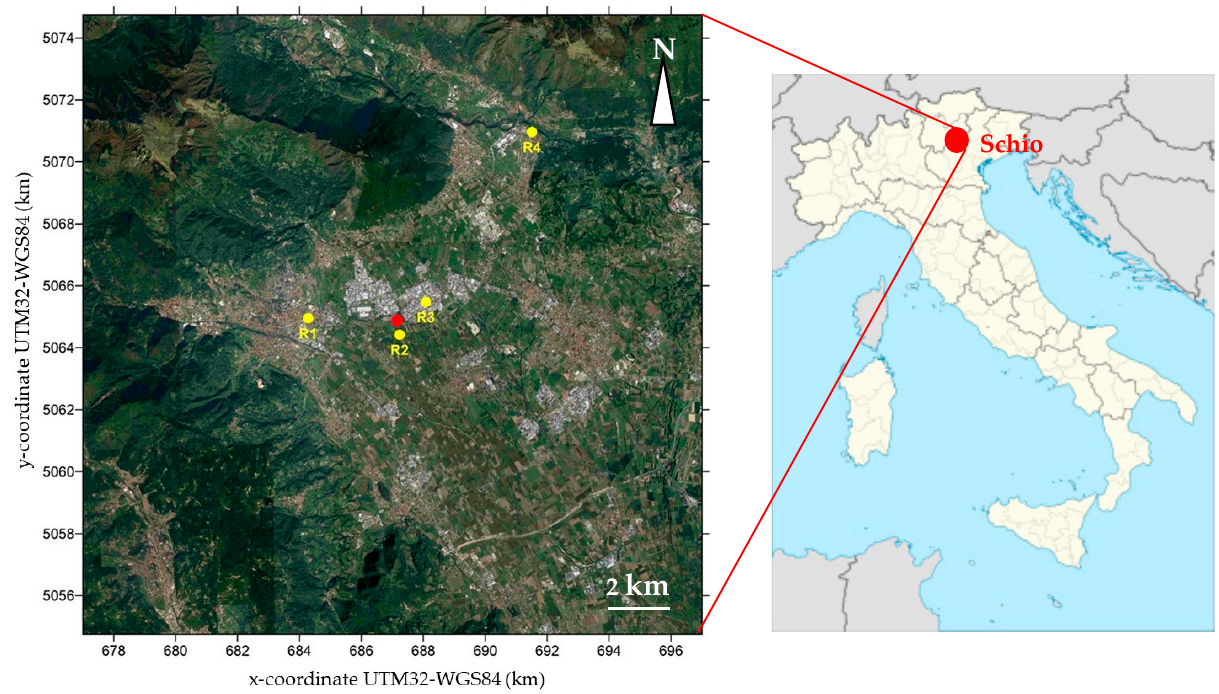
Figure 1. Modelling domain with plant (red dot) and discrete receptors’ (yellow dots) location.